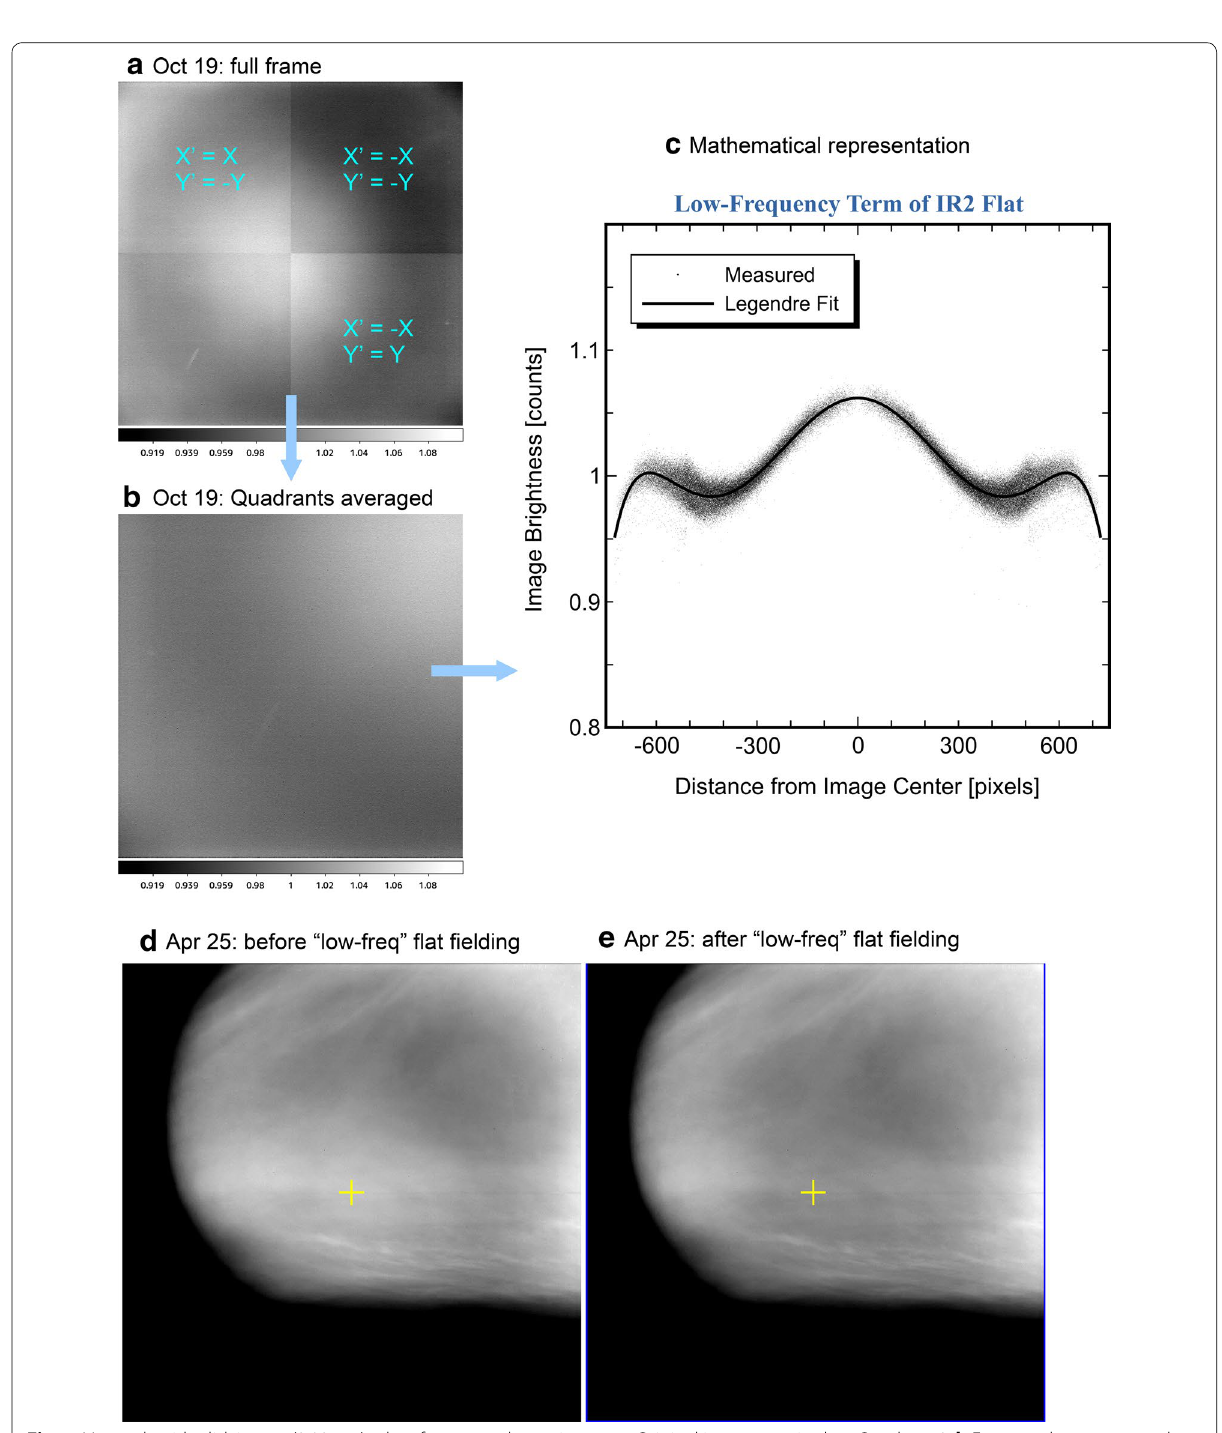
Fig. 5 Venus dayside disk image (2.02 μm) taken from near the pericenter. a Original image acquired on October 19. b Four quadrants averaged to reduce the cloud pattern (considered as the “low‑frequency” flat). c A mathematical representation of measured brightness variation as a function of distance from the image center. d Example of 2.02‑μm image (acquired on April 25) with a large Venus disk. e After application of “low‑frequency” flat. See text for